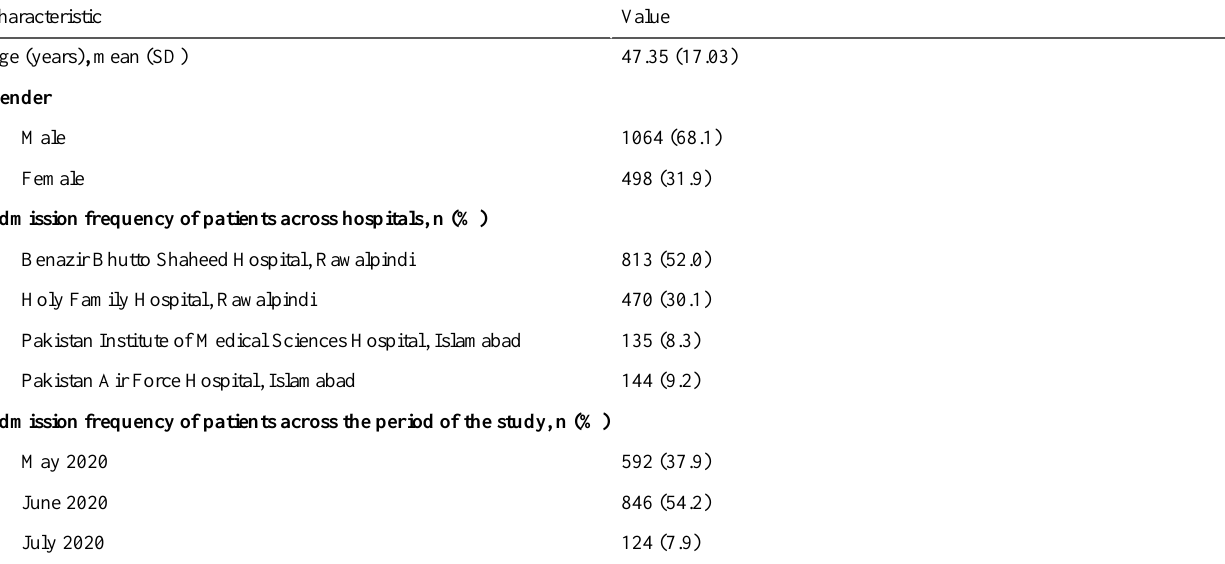
Table 1. Baseline characteristics of the study participants